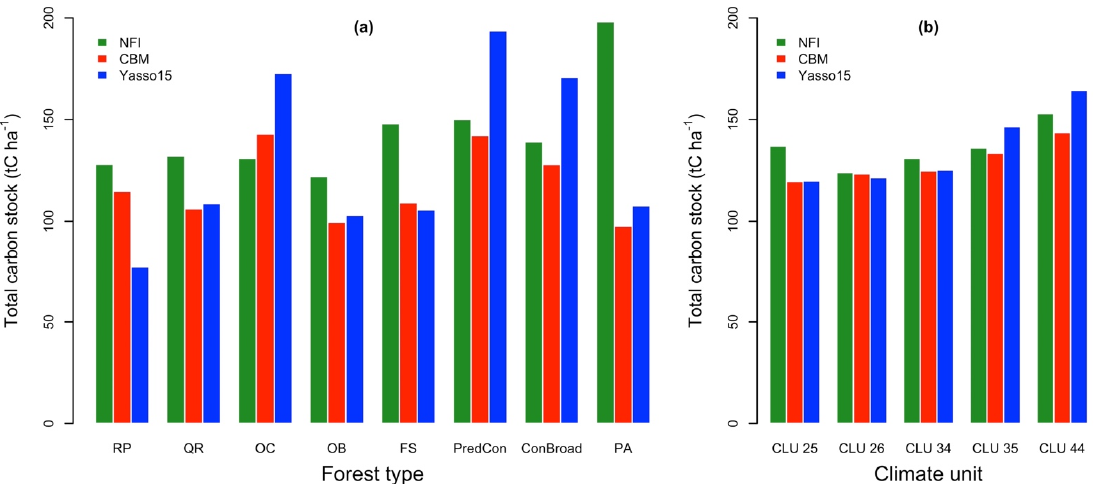
Figure 3. Measured and modeled initialized total C stock (tC ha − 1 ) on forest types ( a ) and on CLUs ( b ). Forest types and CLUs are represented following the altitude increase, from left to right. Decreasing number in the CLU indicates increase in mean annual temperature. See the abbreviations for the forest types in Table 1.